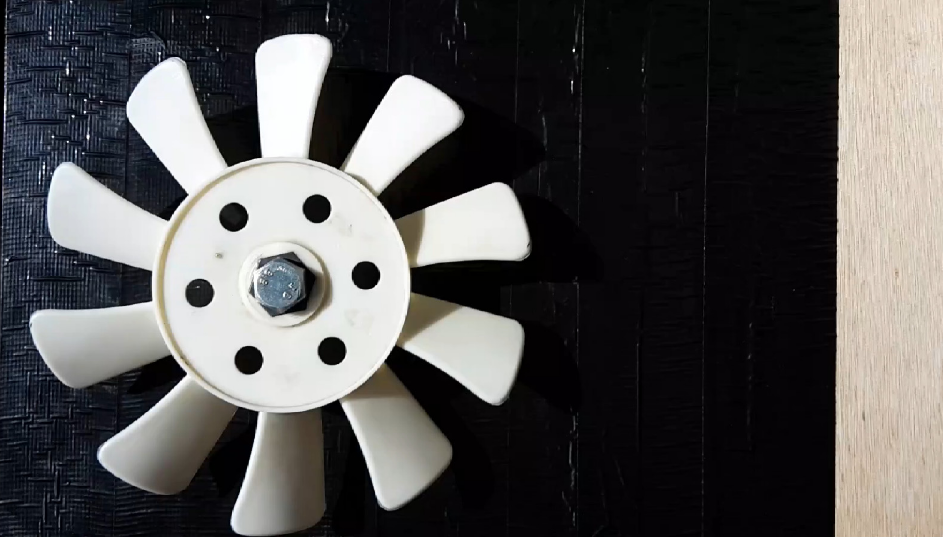
Figure 1. The first frame of the video, digitalized as a 1080 × 1920 × 3 matrix: full-HD resolution of 1920 × 1080 (16:9 aspect ratio), where each pixel color is represented as a triplet of intensities for the three-color components namely red, green, and blue (RGB additive trichromacy color model).